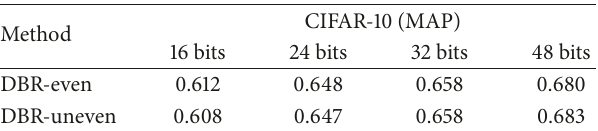
Table 4: MAP of image retrieval on CIFAR-10 dataset with 4 different bit lengths. We use 1000 query images and calculate the MAP within top 5000 returned neighbors. The first line is the result of semantically even situation and the second is semantically uneven situation.